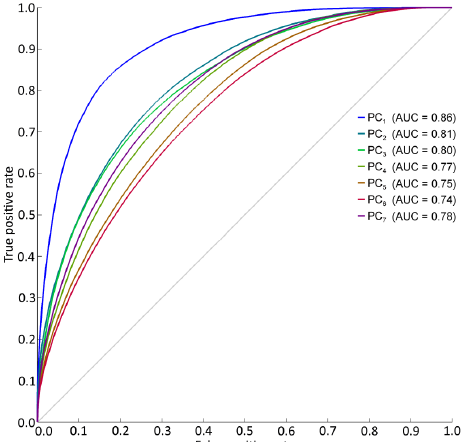
Figure 9. Receiver operating curves for modeled classified storm damage probability and the associated area under curve ( AUC ) values.